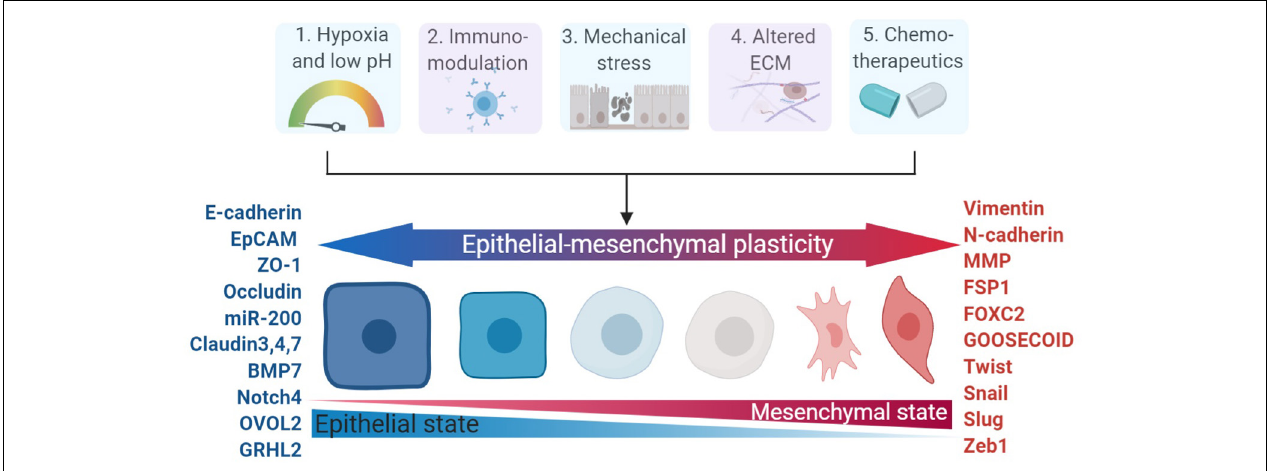
FIGURE 1 | Major categories of EMP stimuli and markers involved in EMP. The dynamics of the epithelial – mesenchymal spectrum can be induced by five major stimulii (hypoxia, immuno-modulators, mechanical stress, altered ECM, and chemotherapeutics), which involve changes in various functional and morphological states and enlisted markers across the spectrum of epithelial–mesenchymal plasticity. ECM, extracellular matrix.